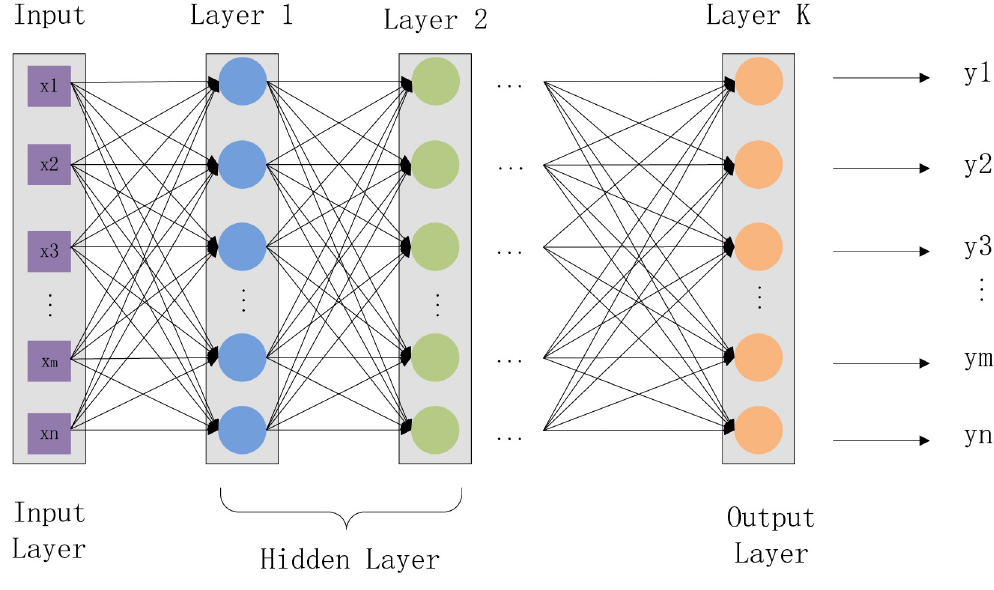
Fig 2. A simple Multi-Layer Perceptron